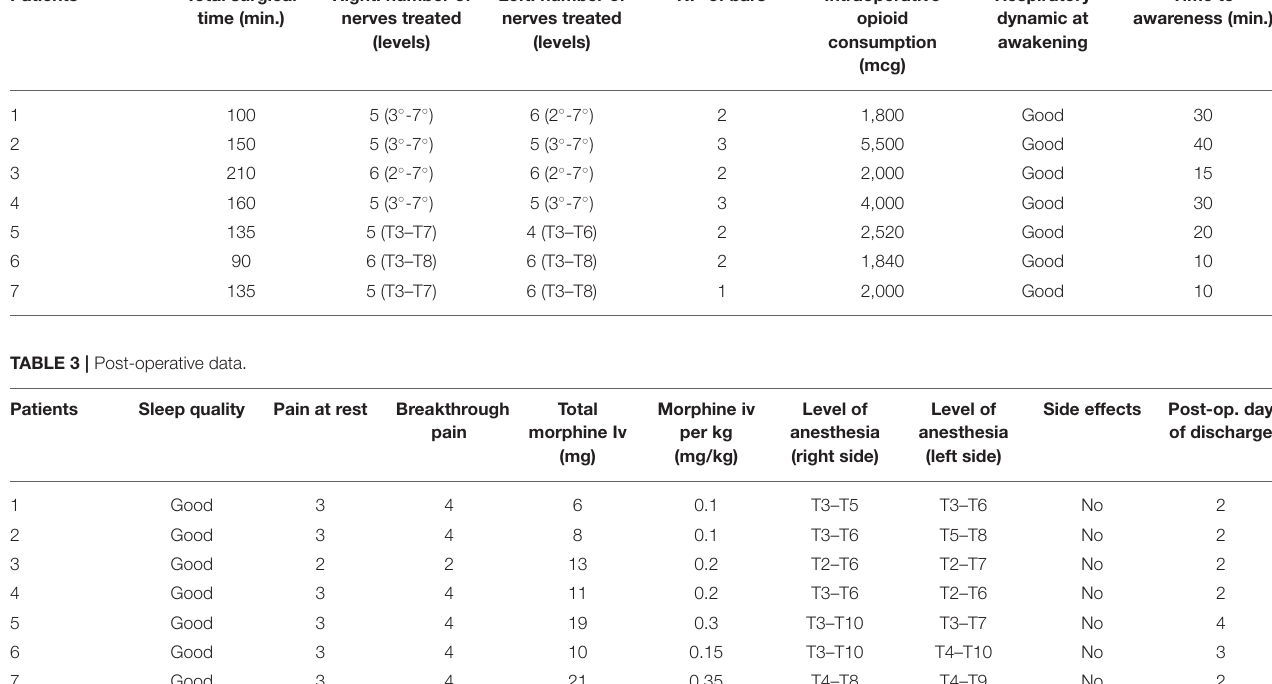
TABLE 2 | Intraoperative data. Patients Total surgical time (min.)